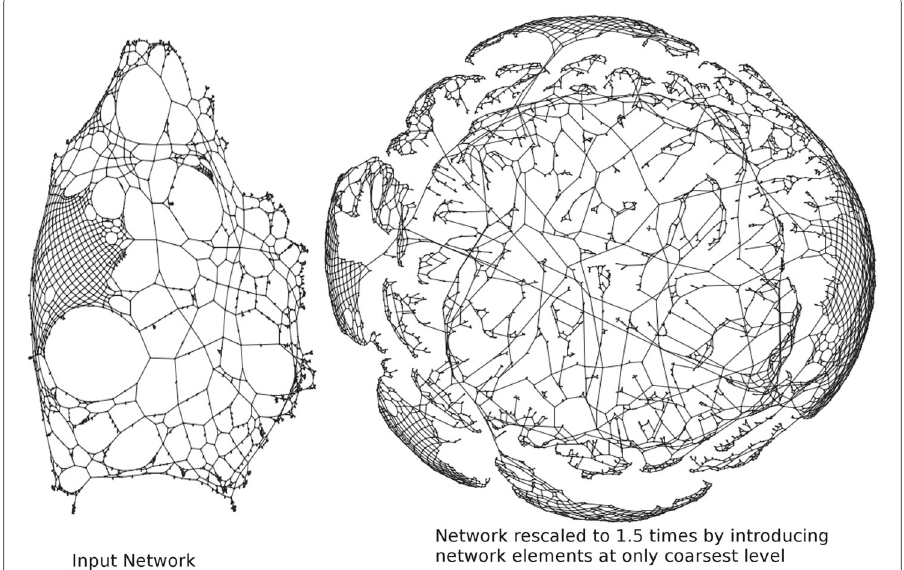
Fig. 24 Visualization of a road network from roadNet-TX with 2001 nodes and 2957 edges rescaled to at least 5028 nodes and 7375